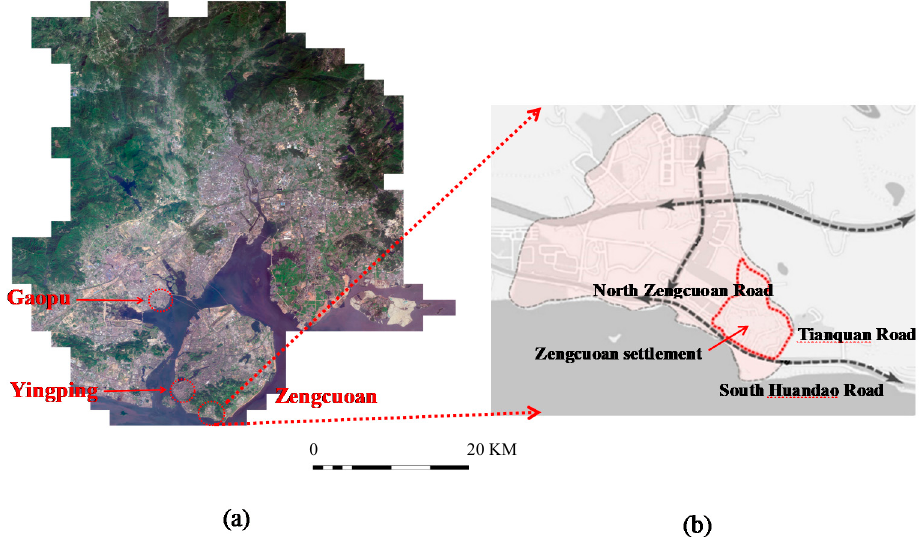
Figure 2. ( a ) Location of three coastal settlements in Xiamen City, China; ( b ) roads of Zengcuoan Figure 2. ( a )LocationofthreecoastalsettlementsinXiamenCity, China; ( b settlement.